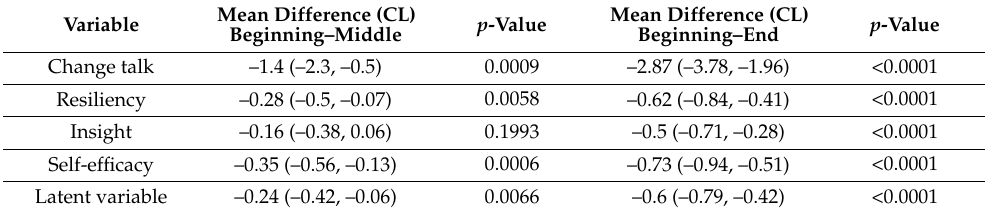
Table 5. Analysis of variance (ANOVA) with a fixed effect of time (beginning, middle, end) *.